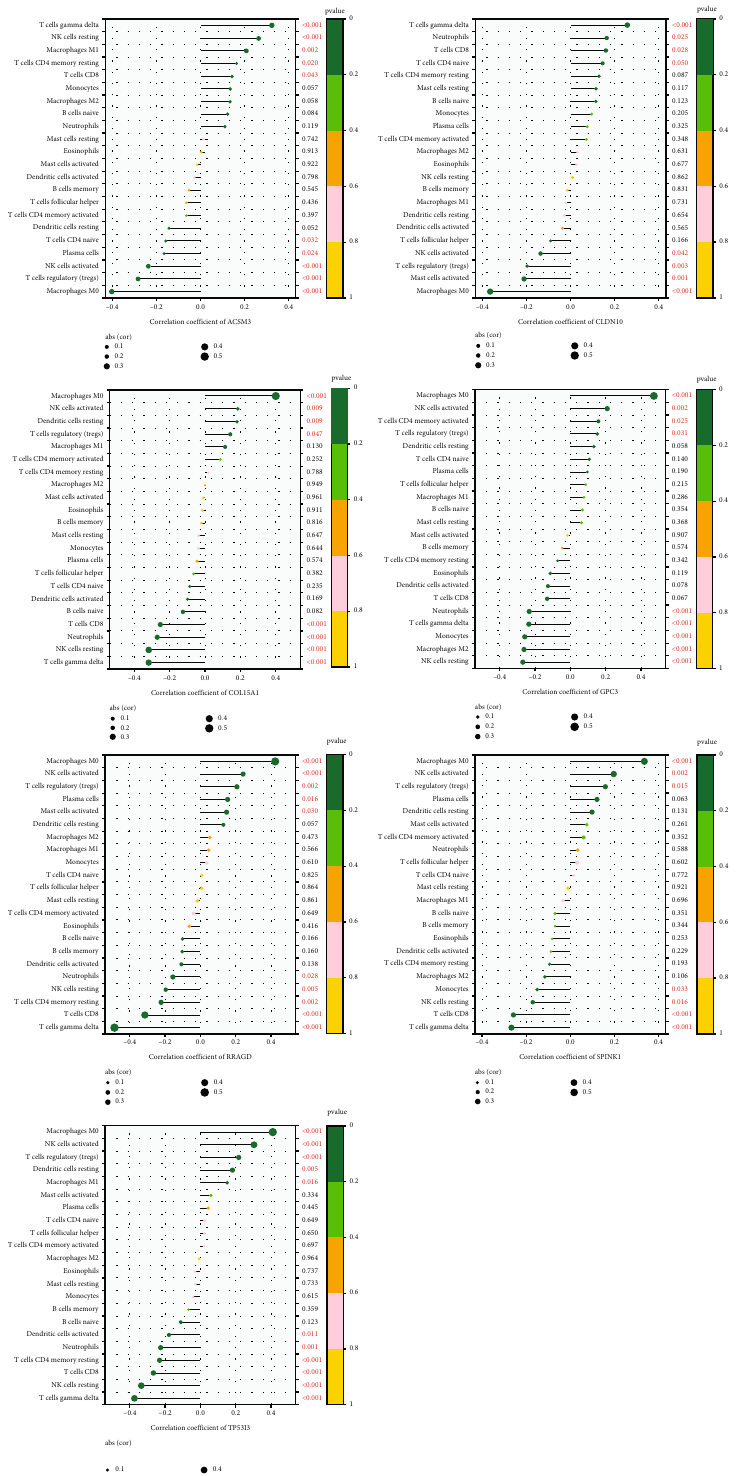
Figure 8: Correlation analyses between diagnostic gene biomarkers and in fi ltrating immune cells in HCC. Correlation between GPC3, ACSM3, SPINK1, COL15A1, TP53I3, RRAGD, CLDN10, and in fi ltrating immune cells. The size of the dots represents the strength of the correlation between feature genes and immune cells; the larger the dots, the stronger the